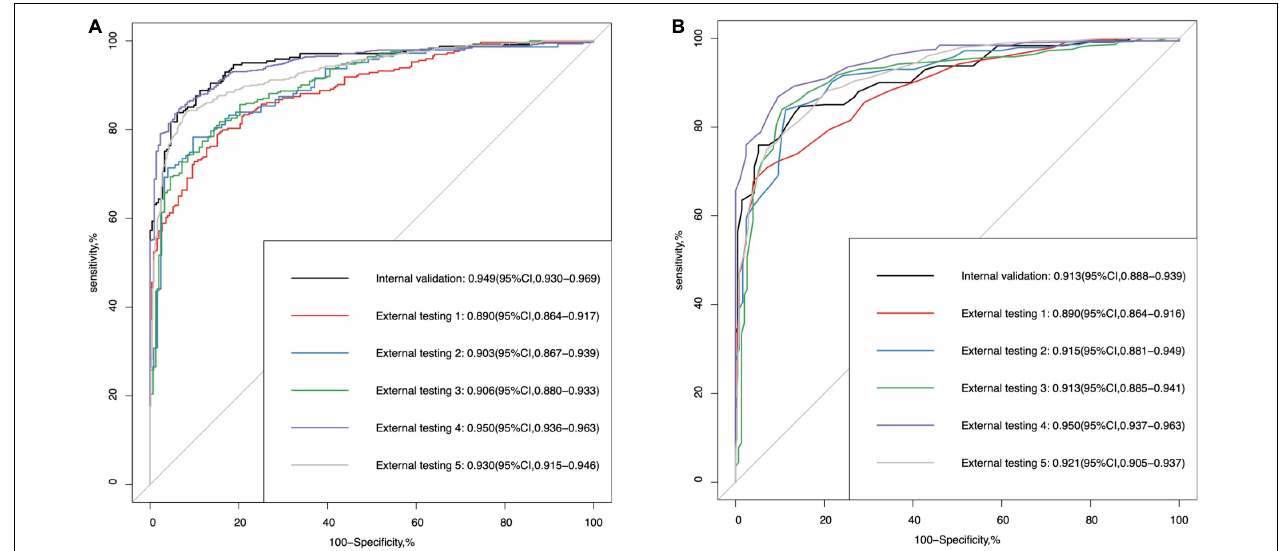
FIGURE 2 | The area under the receiver operating characteristic (ROC) curve (AUROC) values of (A) the multi-task deep learning model and (B) retinal nerve fibre layer thickness in internal validation and external testing for glaucomatous optic neuropathy detection.